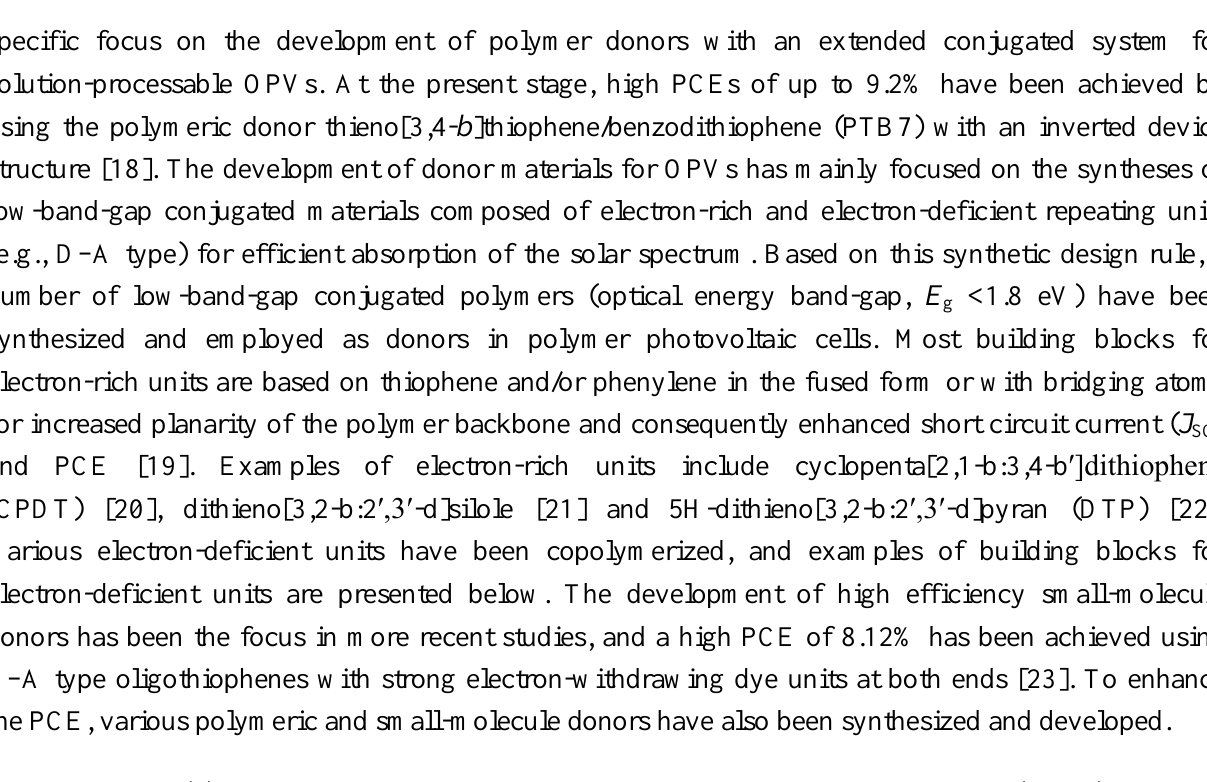
( b ) molecular structures of P3HT ( D1 ), PC